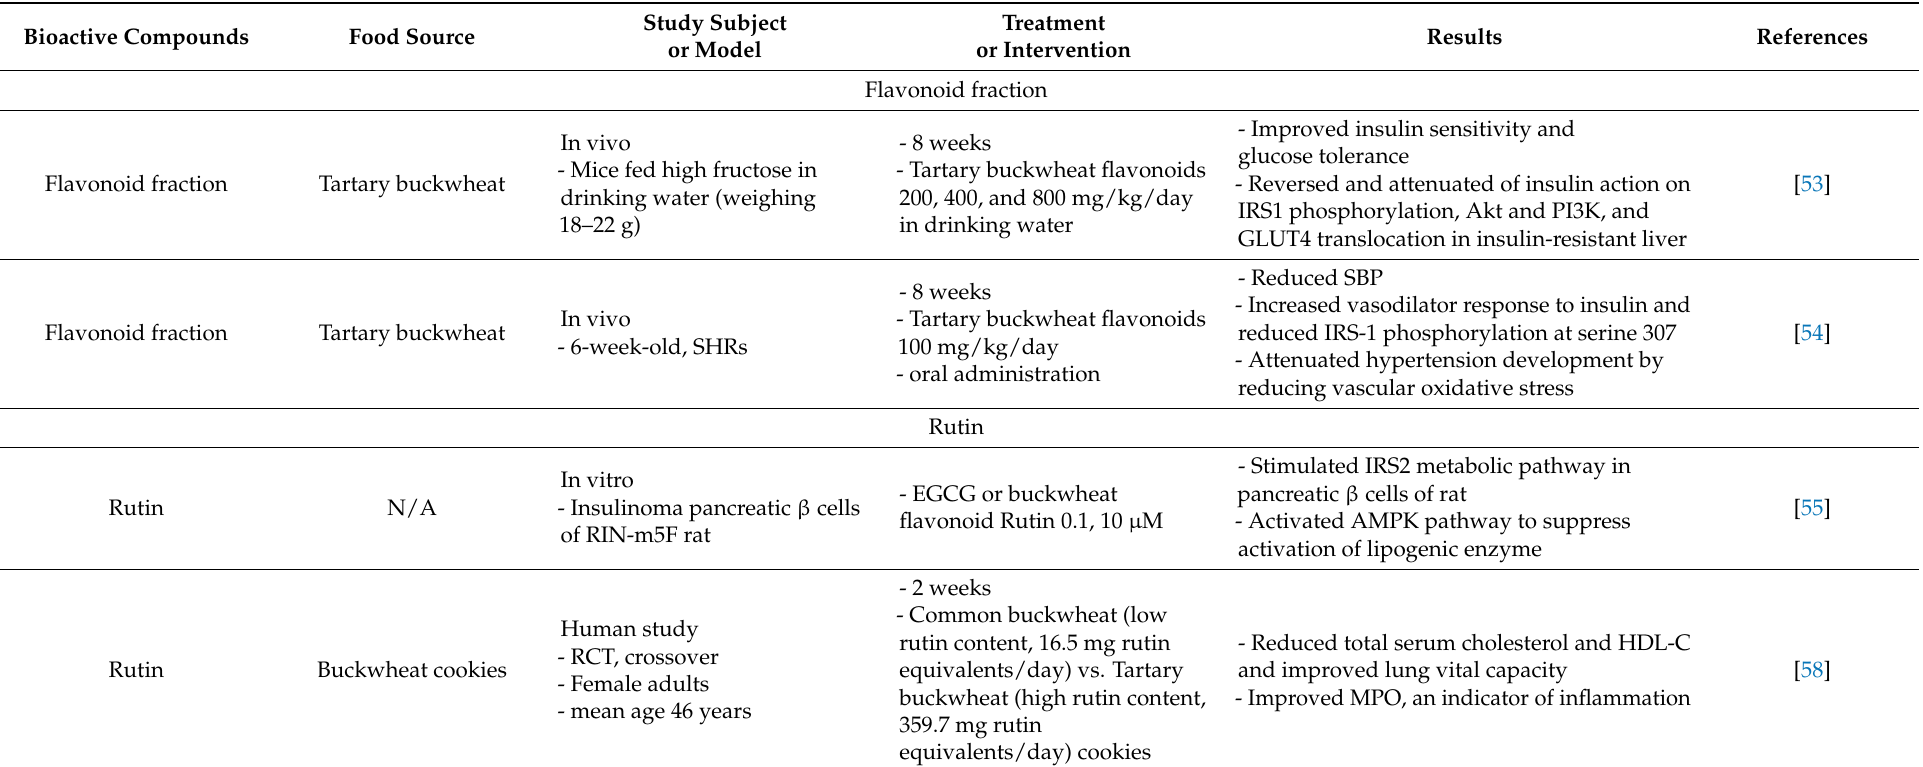
Table 2. Effects of flavonoids on cardiovascular and metabolic